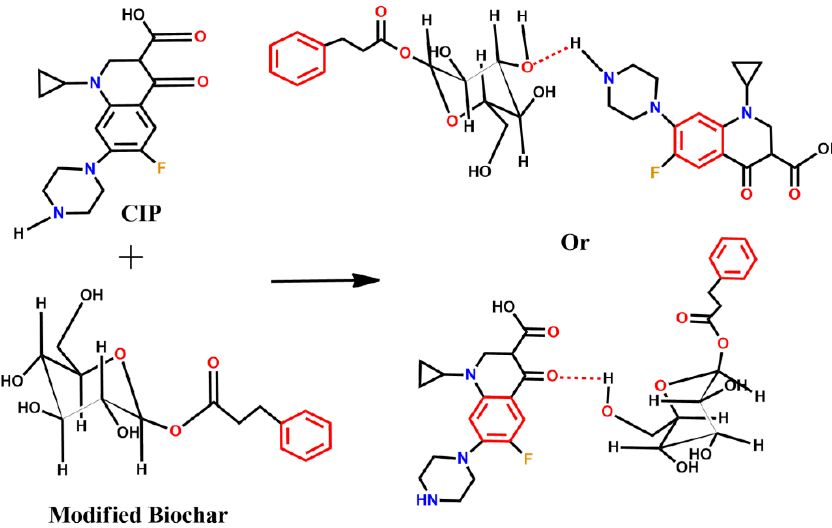
Figure 10. Interaction mechanism of CIP in neutral form ( a ) and zwitterion form ( b ) with modified biochar based on HOMO and LUMO.